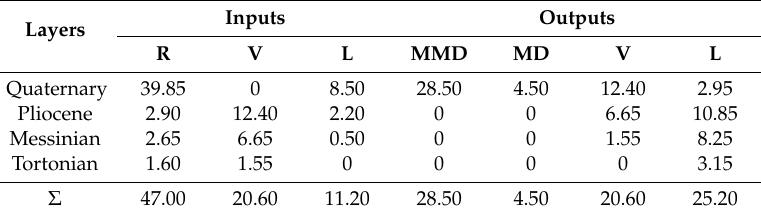
Table 4. Water-balance results for the Campo de Cartagena model in the steady state (1925) (Mm 3 /yr). Layers